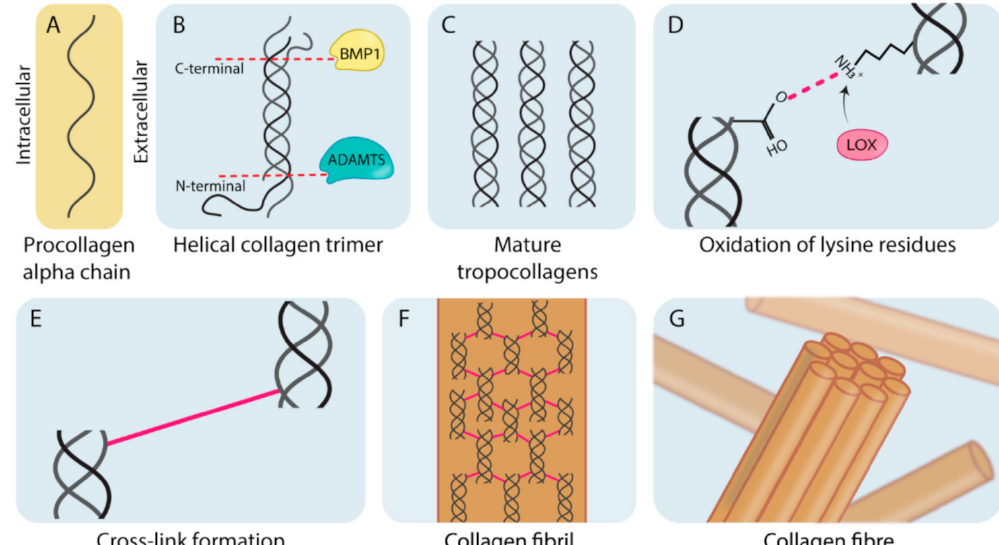
Figure 1. The biogenesis of fibrillar collagens. ( A ) Pro-collagen alpha-chain subunits are synthesized intracellularly by cells (predominantly fibroblast-like cells). ( B ) These alpha chains are assembled into helical collagen trimers in the endoplasmic reticulum and are then secreted into the extracellular space where they undergo post-translational processing by bone morphogenetic protein 1 (BMP1) and a disintegrin and metalloproteinase with thrombospondin motifs (ADAMTS). ( C ) Cleavage results in the formation of mature tropocollagen. ( D ) The lysyl oxidase (LOX) family members catalyze oxidative deamination of the lysine residues on the mature tropocollagen chains. ( E ) Deaminated residues on adjacent chains spontaneously condense and result in a cross-link. ( F ) Cross-linked tropocollagens organize to form collagen fibrils. ( G ) Collagen fibrils are further organized and assembled into collagen